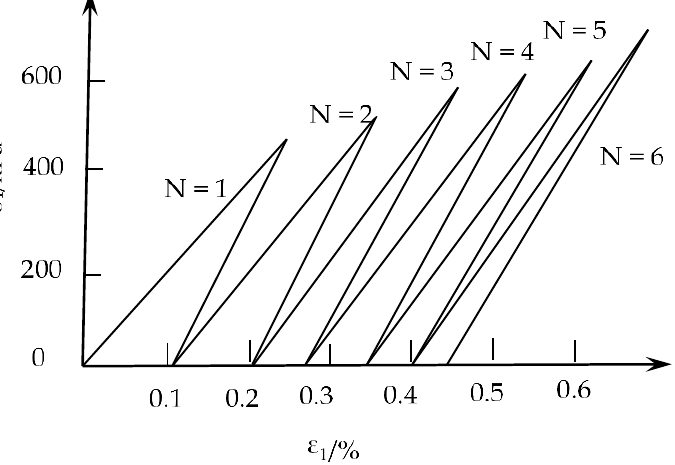
Figure 2. Schematic diagram of the stress–strain relationship for repeated DC [24] ( N is the tamping times of DC).